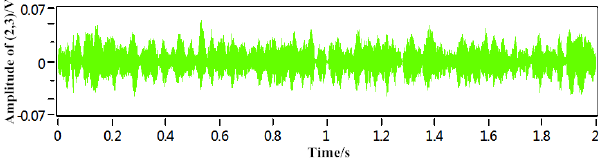
Figure 11. Reconstruction signals of the vibration of the fault motor.